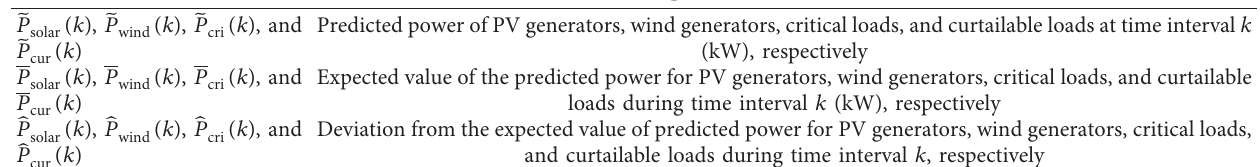
Table 2: Predicted parameters.